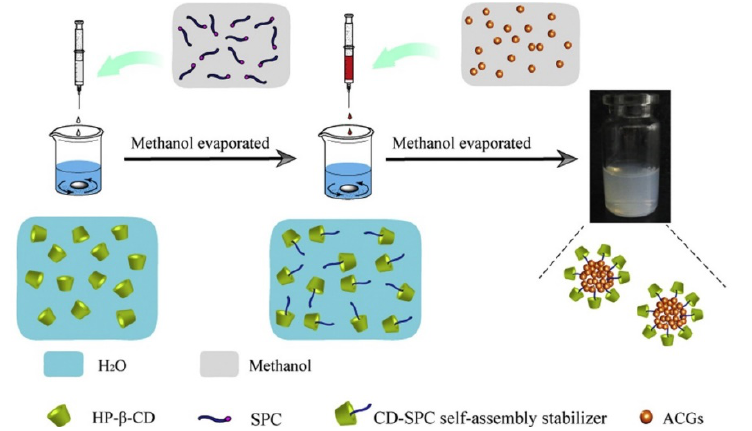
Figure 4. Diagram of the SMPMs synthesis to encapsulate Annona cherimolia acetogenins. (Repro- duced from 10.1016/j.colsurfb.2016.05.012 with permission from Elsevier B.V. under License Number: 5039230526812) [75]. Table 3. SMPMs: Reported values of acetogenins.